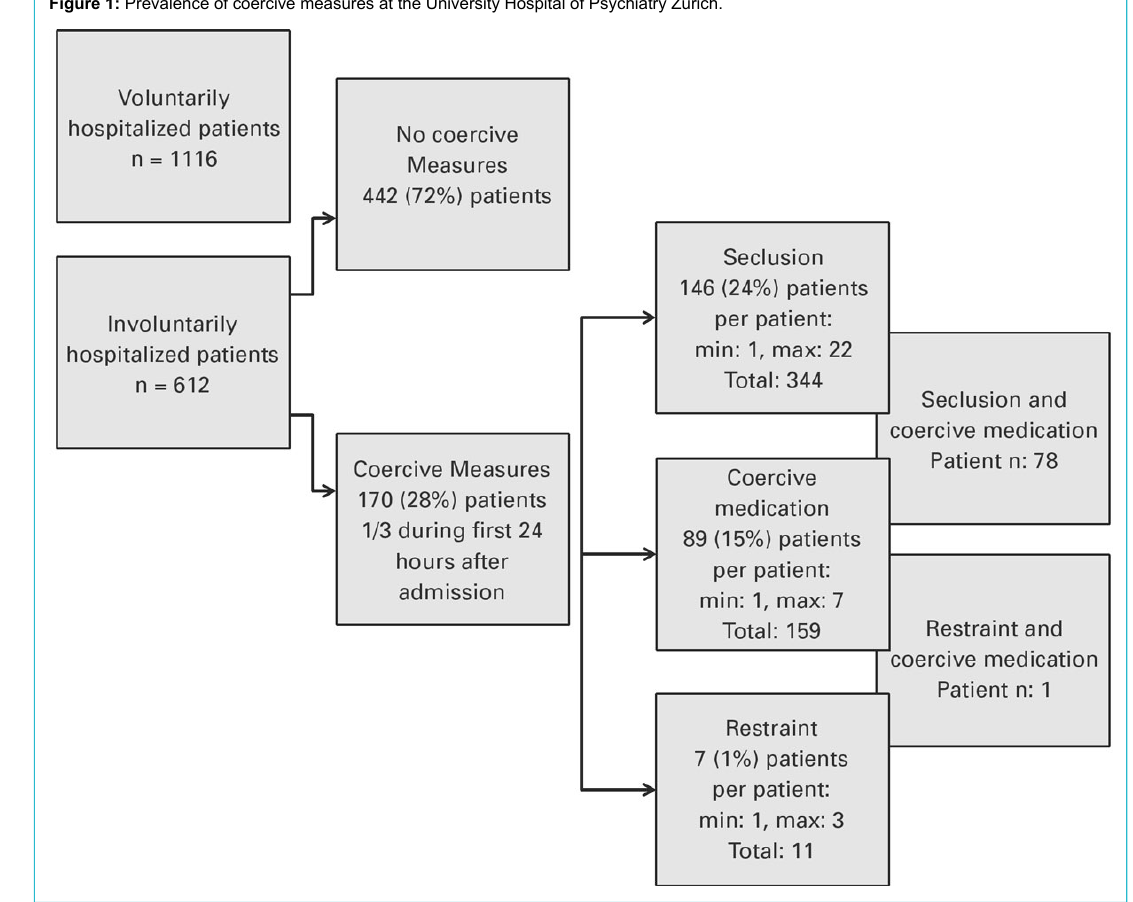
Figure 1: Prevalence of coercive measures at the University Hospital of Psychiatry